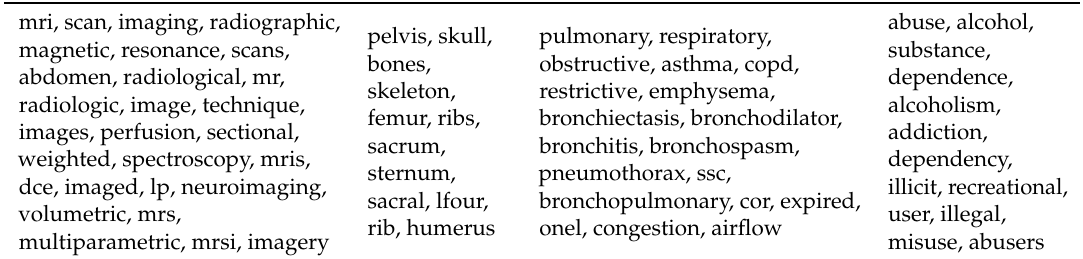
Table 7. Samples of clustered